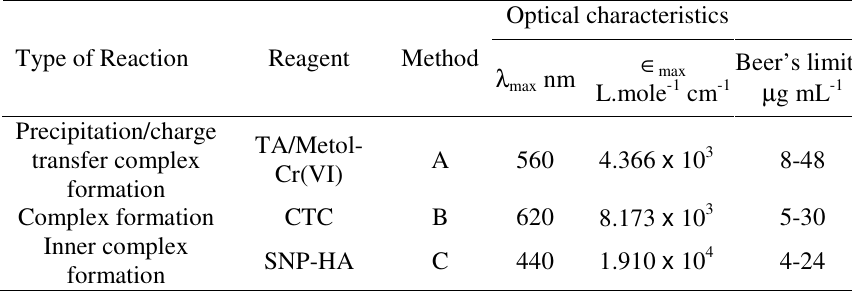
Table 1. Proposed and reported visible spectrophotometric